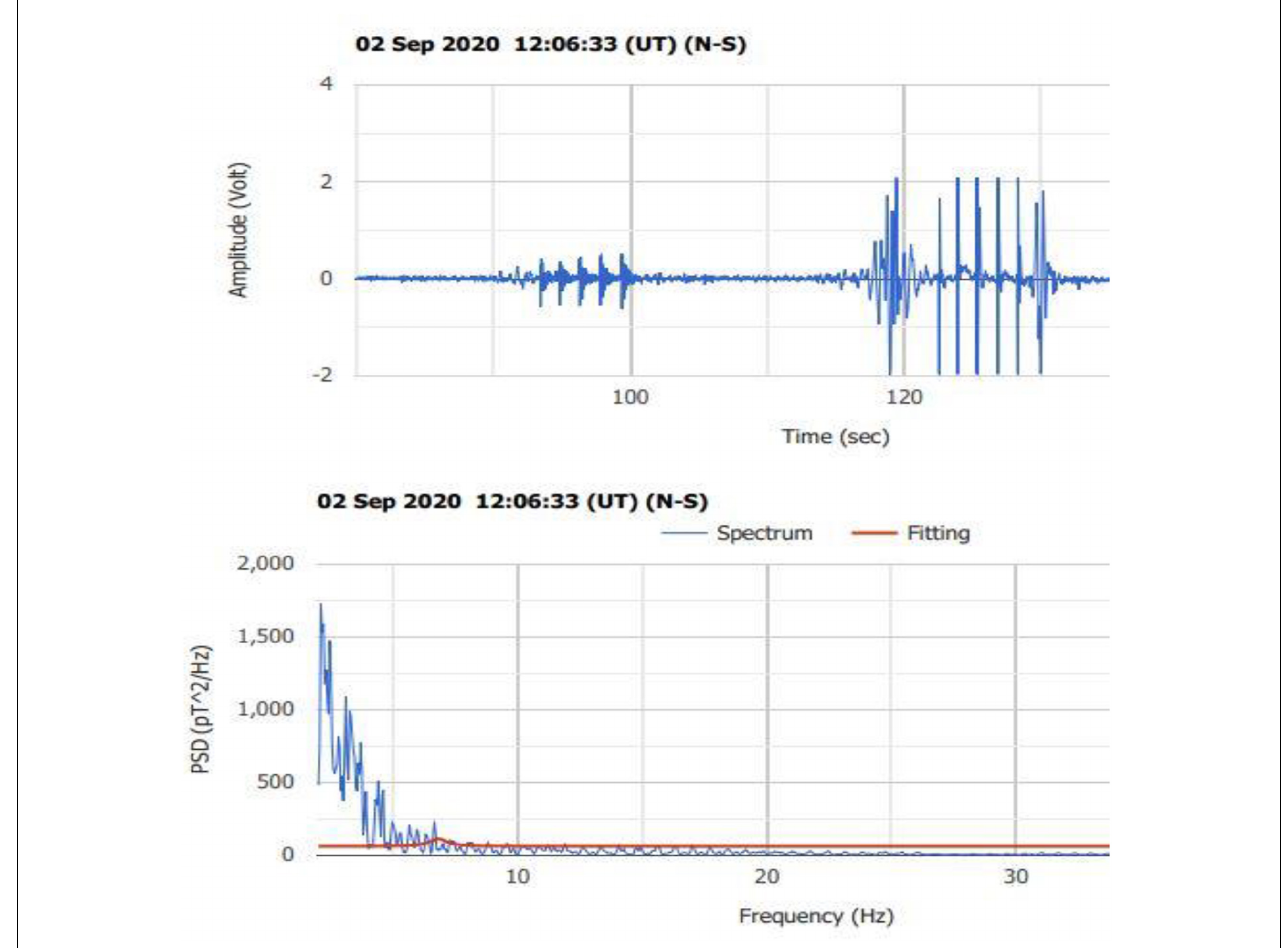
FIGURE 12 | Magnified snapshot of Figure 11 . The short five knocks on the door and the five strong knocks on the window are evident.